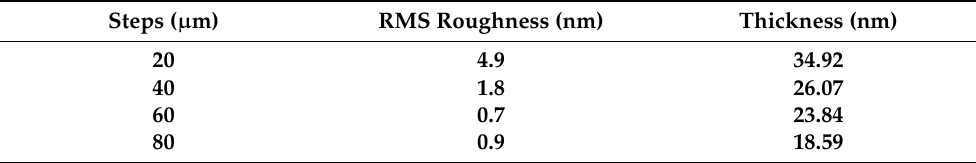
Table 2. Morphology performance of inkjet-printed perovskite film using different